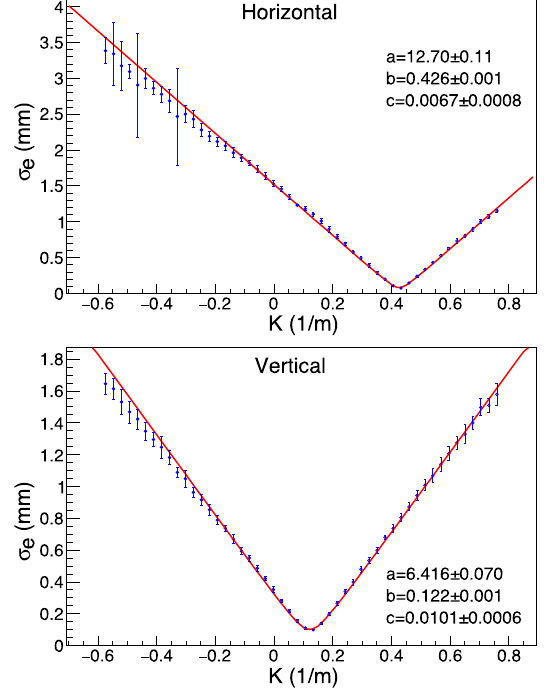
FIG. 21. Measurement of emittance with LCS operation mode. The red line is the fitted curve with a parabolic function.